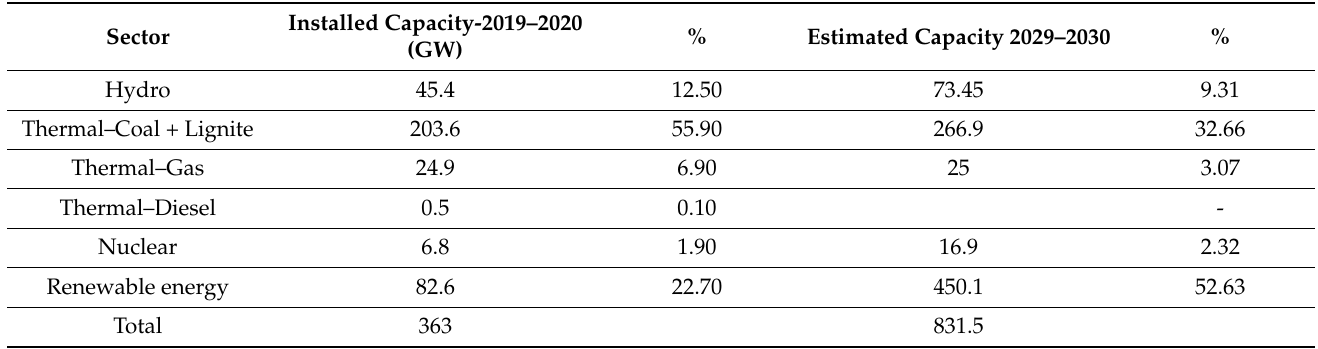
Table 2. Distribution of electricity generation capacity 2019–2020 and projected distribution for 2029–2030 [50].